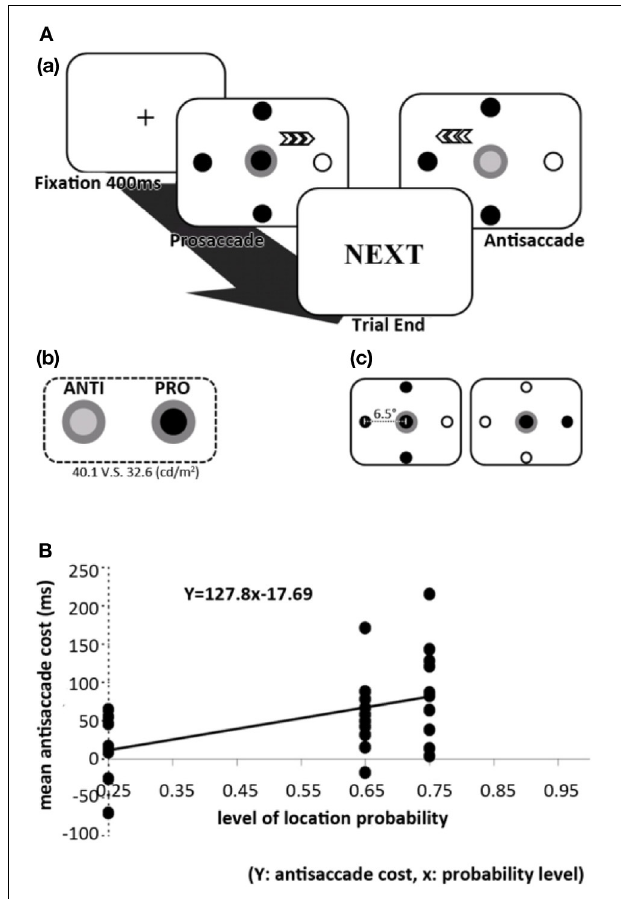
FIGURE 2 | (A) The spatial orienting paradigm used in Liu et al. (2010, 2011). Participants were shown a central disc that cued either a prosaccade or antisaccade. This paradigm is able to manipulate levels of probability in prosaccade locations but not antisaccade locations. Behavioral results suggested that these two types of saccades can indeed be dissociated since the effect of probability in prosaccade is not transferred to the same location in an antisaccade. (B) Effect of spatial probability on antisaccade cost and SRT from Liu et al. (2010, 2011). This figure shows how the magnitude of antisaccade cost correlates linearly with the level of prosaccade probability. This is because the prosaccades are facilitated by spatial probability while antisaccade SRT remained relatively similar, thereby creating bigger discrepancies between the two SRTs (antisaccade cost).